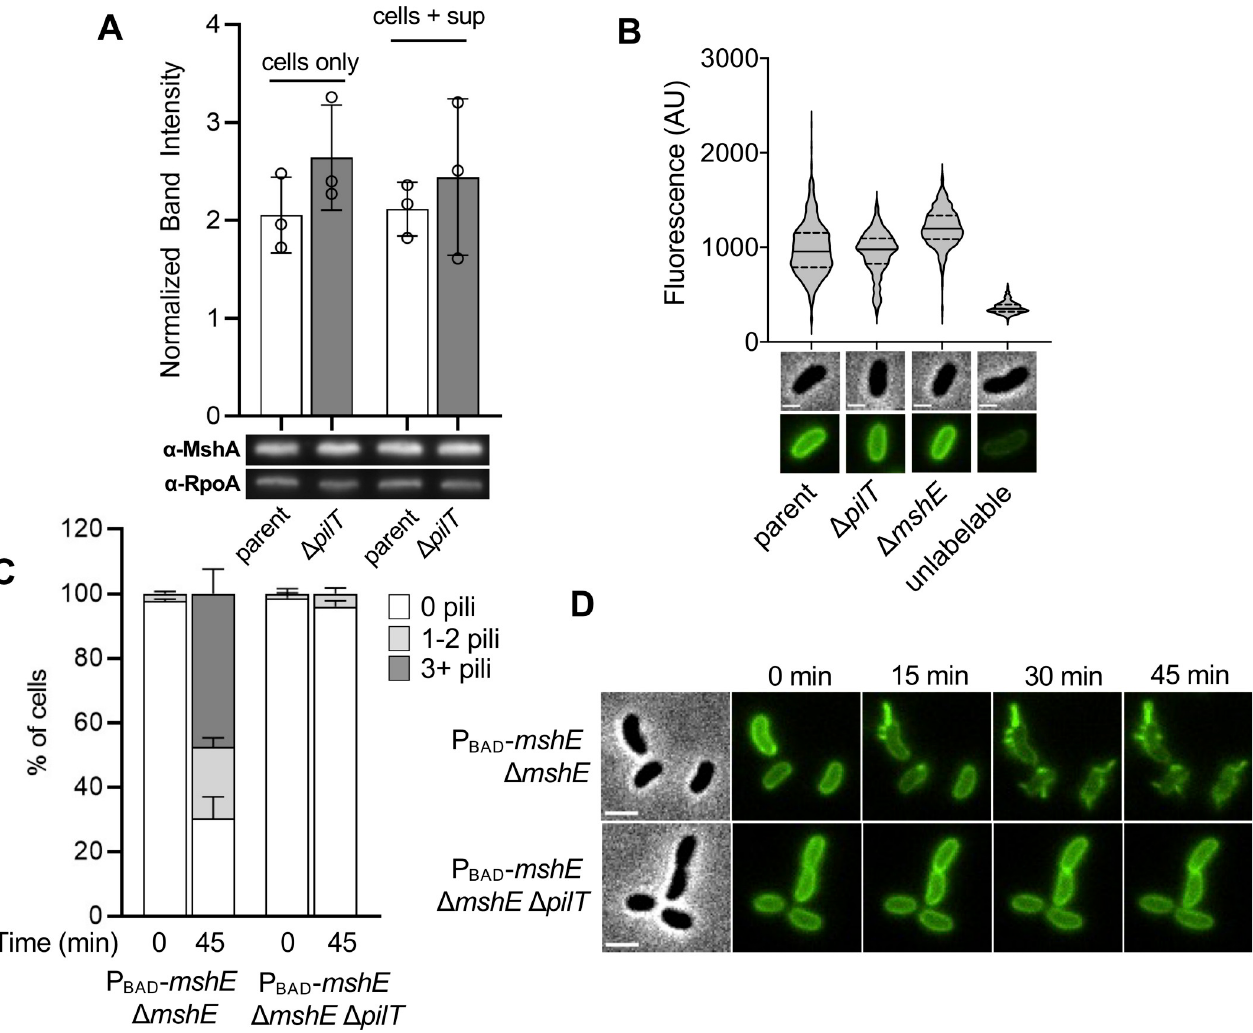
Fig 2. Reduced MSHA piliation of Δ pilT cells is likely due to a lack of pilus biogenesis rather than “runaway” extension. ( A ) Western blot analysis of MshA protein levels in parent and Δ pilT strains. Samples represent either cell-associated major pilin (cells only) or cell associated + pili shed in the supernatant (cells + sup). Band intensities are normalized to the RpoA loading control for quantification. Data are from three independent biological replicates. Data are displayed as the mean ± SD. ( B ) Quantification of cell body fluorescence in AF488-maleimide labeled cells as indicated. The parent, Δ pilT , and Δ mshE strains contain the mshA T70C mutation required for labeling the major pilin, while the unlabelable strain lacks this mutation. The latter is included here to denote the background cell body fluorescence observed in the absence of major pilins that can be labeled. The fluorescence of unpiliated cells was analyzed (as a measure of major pilin load in the inner membrane), and n � 600 cells from three independent biological replicates for each strain. Data are presented as violin plots that demarcate the median (solid line) and quartile range (dotted lines). Representative images of cells used for quantification are included below. Phase images show cell boundaries and fluorescence images show AF488-mal labeled cells. Lookup tables are equivalent between fluorescence images. Scale bar = 1 μ m. ( C ) Quantification of piliation in the indicated strains before and after induction with 0.2% arabinose. Cells were categorized as either having no pili (white bars), 1–2 pili (light gray bars), or at least 3 pili (dark gray bars). n = 300 cells analyzed from three independent biological replicates for all samples and data are displayed as the mean ± SD. ( D ) Representative montage of timelapse imaging of cells quantified in C . Scale bar = 2 μ